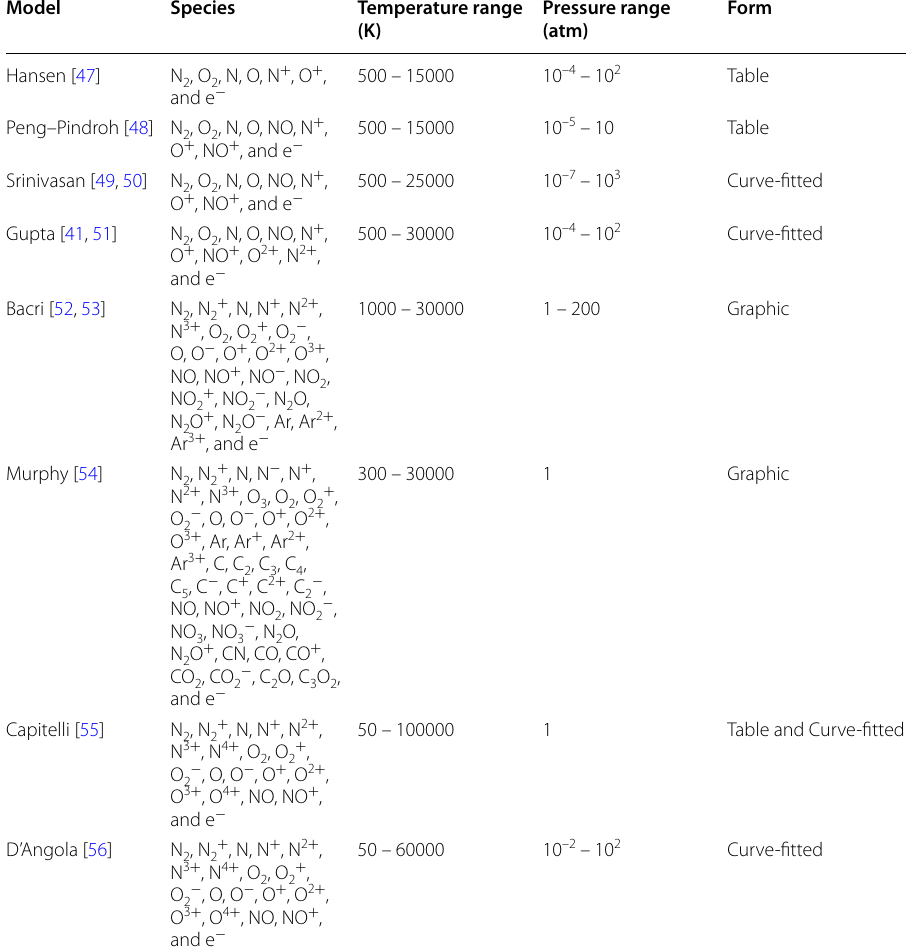
Table 1 Thermodynamic and/or transport properties of the thermochemical equilibrium flow